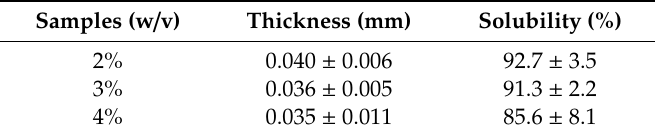
Table 1. Thickness and solubility of the hemicellulose